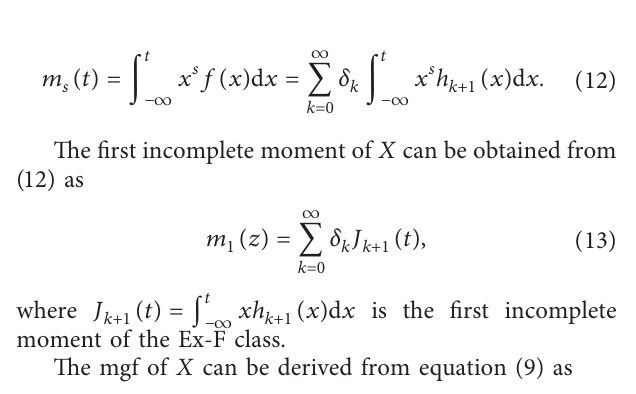
Figure 2: Plots for the hrf of the NE-W